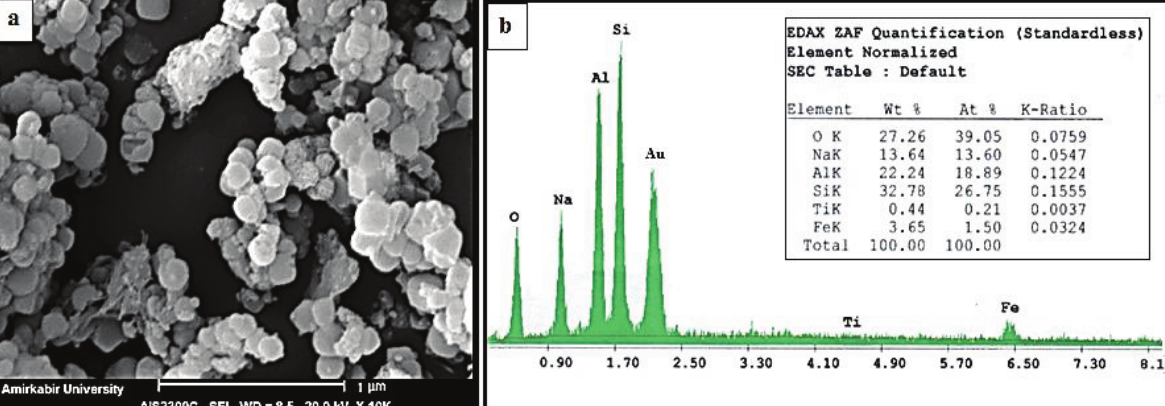
@ 4A, b) TEM image of 4A. Figure 2: SEM images of: a) DOX 5 Figure 2: SEM images of: a) DOX 5